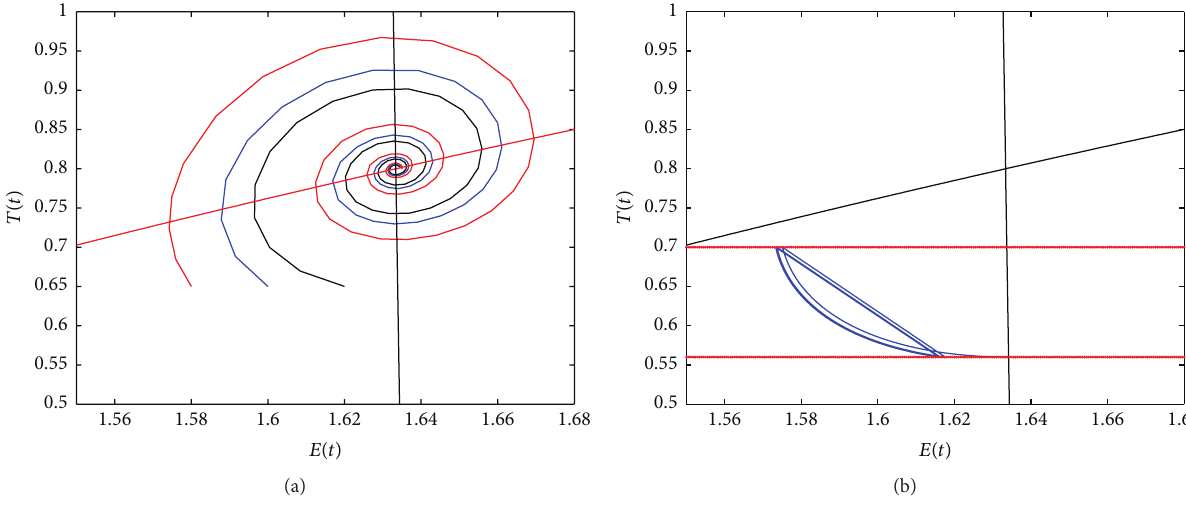
Figure 1: The difference of dynamical behaviors for models (1) and